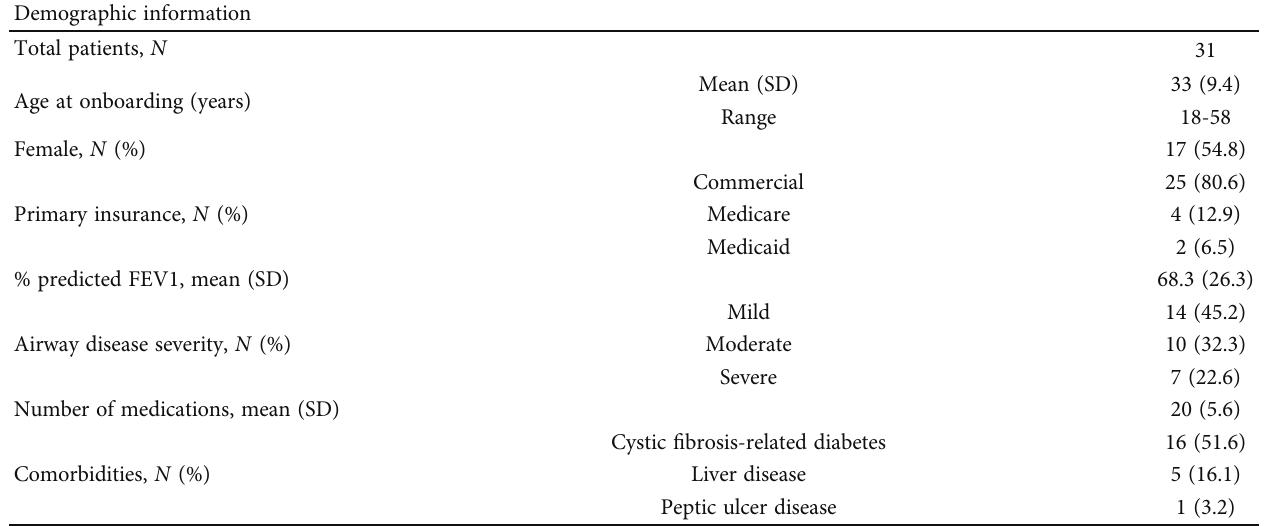
Table 1: Patient